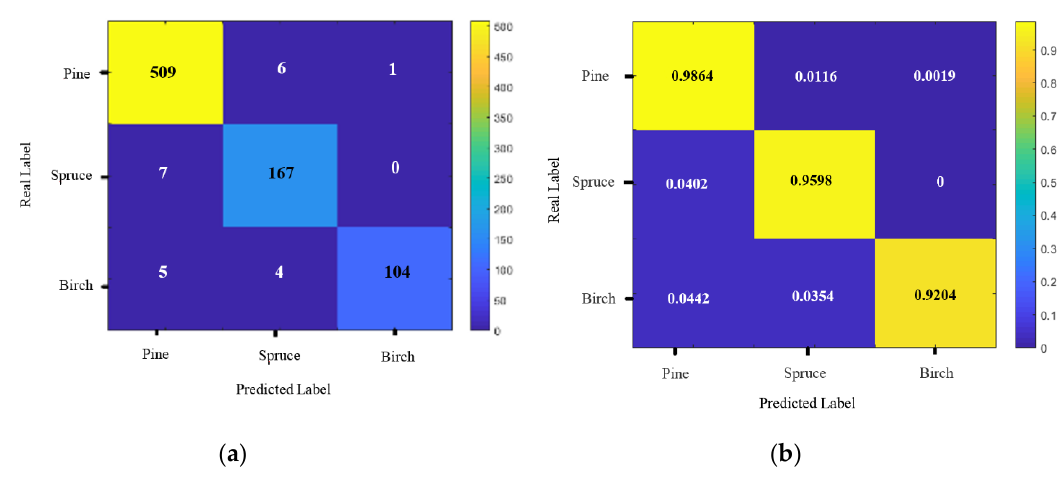
Figure 15. Confusion matrices of the 3D-CNN with only RGB channels; ( a ) case numbers, ( b ) normalized percentages.